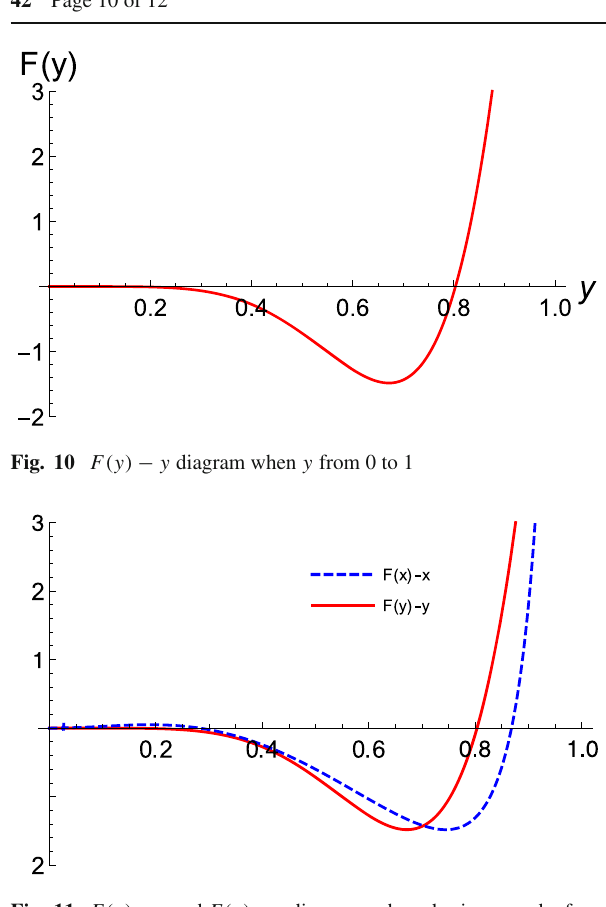
Fig. 11 F ( x ) − x and F ( y ) − y diagrams when abscissa x and y from 0 to